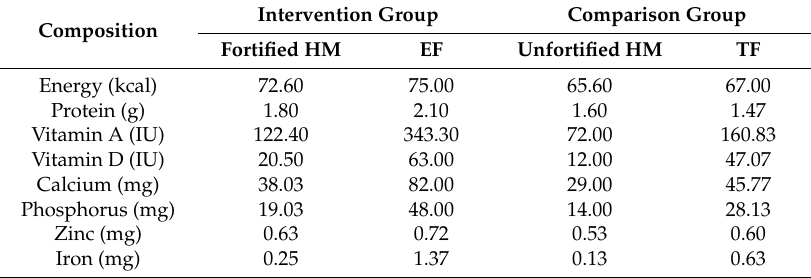
Composition of energy and selected nutrients in fortified human milk (HM) and enriched-nutrient formula (EF) in the intervention group versus unfortified HM and term formula (TF) in the comparison group.